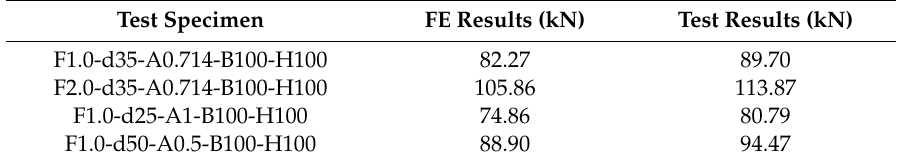
Table 1. The ultimate shear capacity comparison between finite element (FE) and test results. Test Specimen